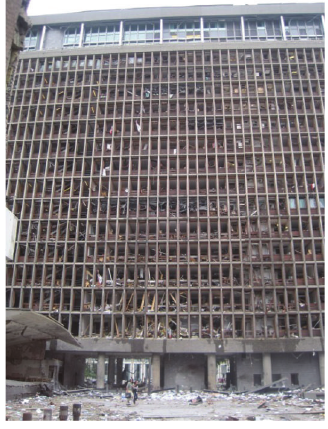
Figure 1: Terrorist attack in Oslo in 2011, failure of windows (from [5]).